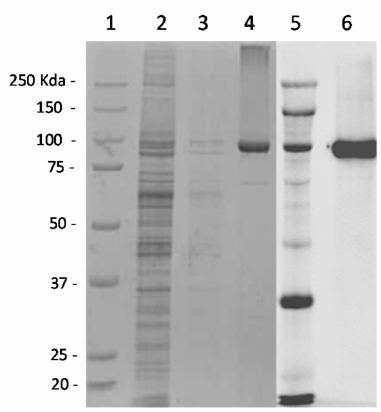
Figure 1. SDS acrylamide gel 10% (tracks 1 to 4) and Western blotting (tracks 5 and 6). Track 1 and 5: Marker Precision Plus protein westernC standard (Biorad, Hercules, CA, USA); track 2: PBS supernatant fraction; track 3: wash fraction; track 4 et 6: Fraction eluted with the Flag peptide.